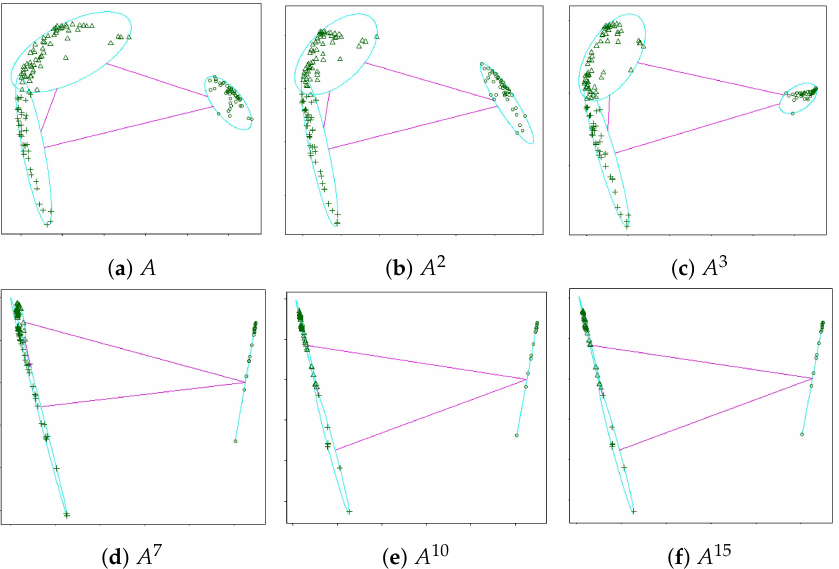
Figure 5. As the ultrametricity of the distance matrix of the Iris data set increases, clusters are better